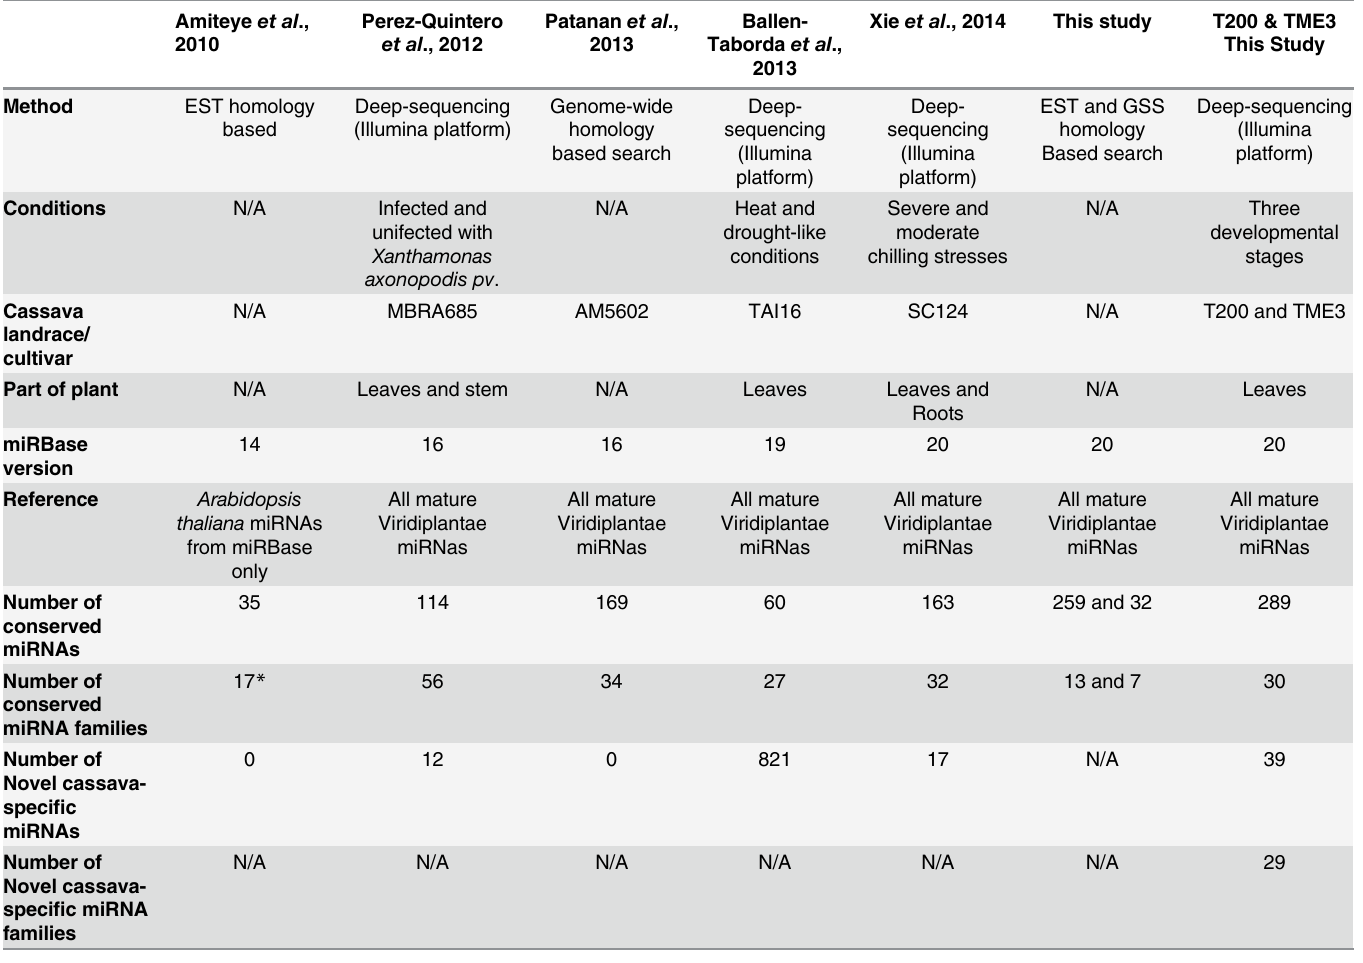
Table 3. Comparison of four previous studies and this study on miRNA identification in